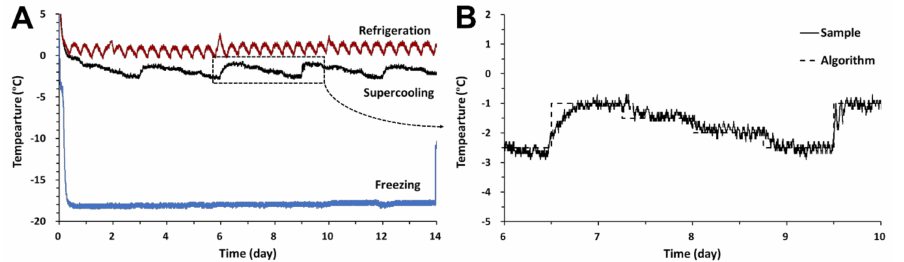
Figure 1. Time–temperature profiles of storage methods ( A ) and stepwise algorithm profiles during supercooling storage of pork belly ( B ); Chicken breast presented a similar pattern (data not shown).